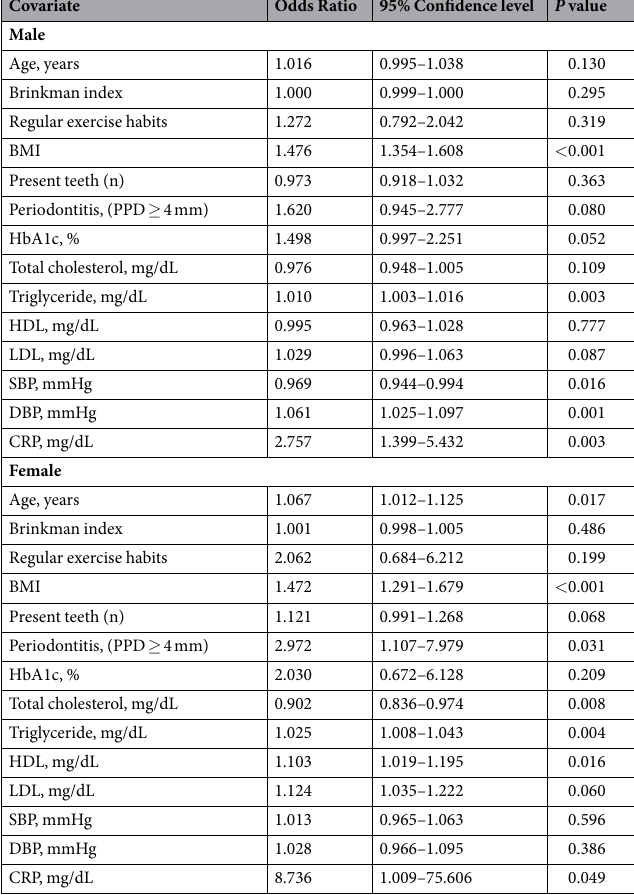
Table 3. Factor associated with NAFLD in Different Populations in Gender by Multivariate Logistic Regression Analysis. Abbreviations: NALFD, non-alcoholic fatty liver disease; F, Female; BMI, body mass index; WC, waist circumference; PPD, probing pocket depth; HbA1c, hemoglobin A1c; HDL, high-density lipoprotein; LDL, low- density lipoprotein; SBP, systolic blood pressure; DBP, diastolic blood pressure; CRP, C-reactive protein.